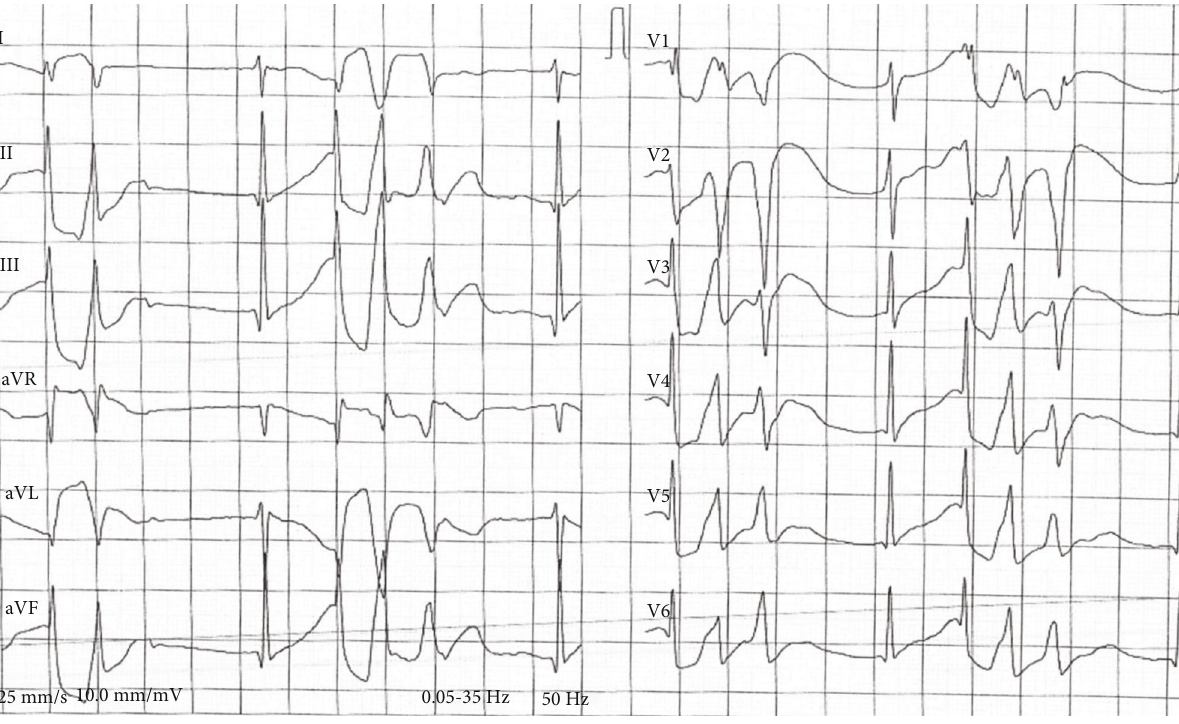
Figure 2: ECG at admission showing QRS widening and ventricular extrasystoles with varying